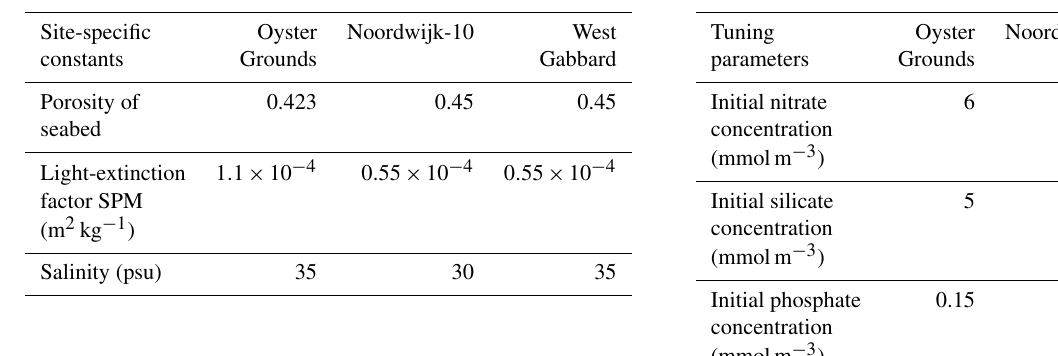
Table 1. Site-specific constants. Table 2. Final values of the model’s tuning parameters.